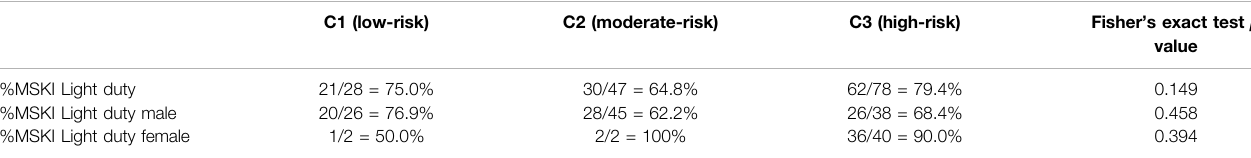
TABLE 4 | Proportion of MOCs with Light Duty Musculoskeletal Injury by Cluster.